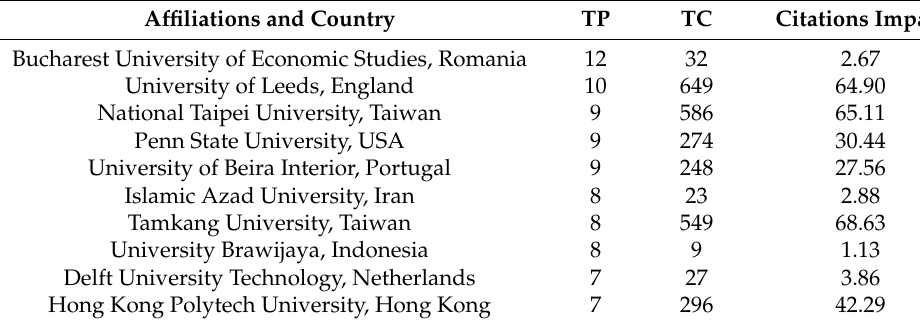
Table 2. Top ten most highly productive organizations.